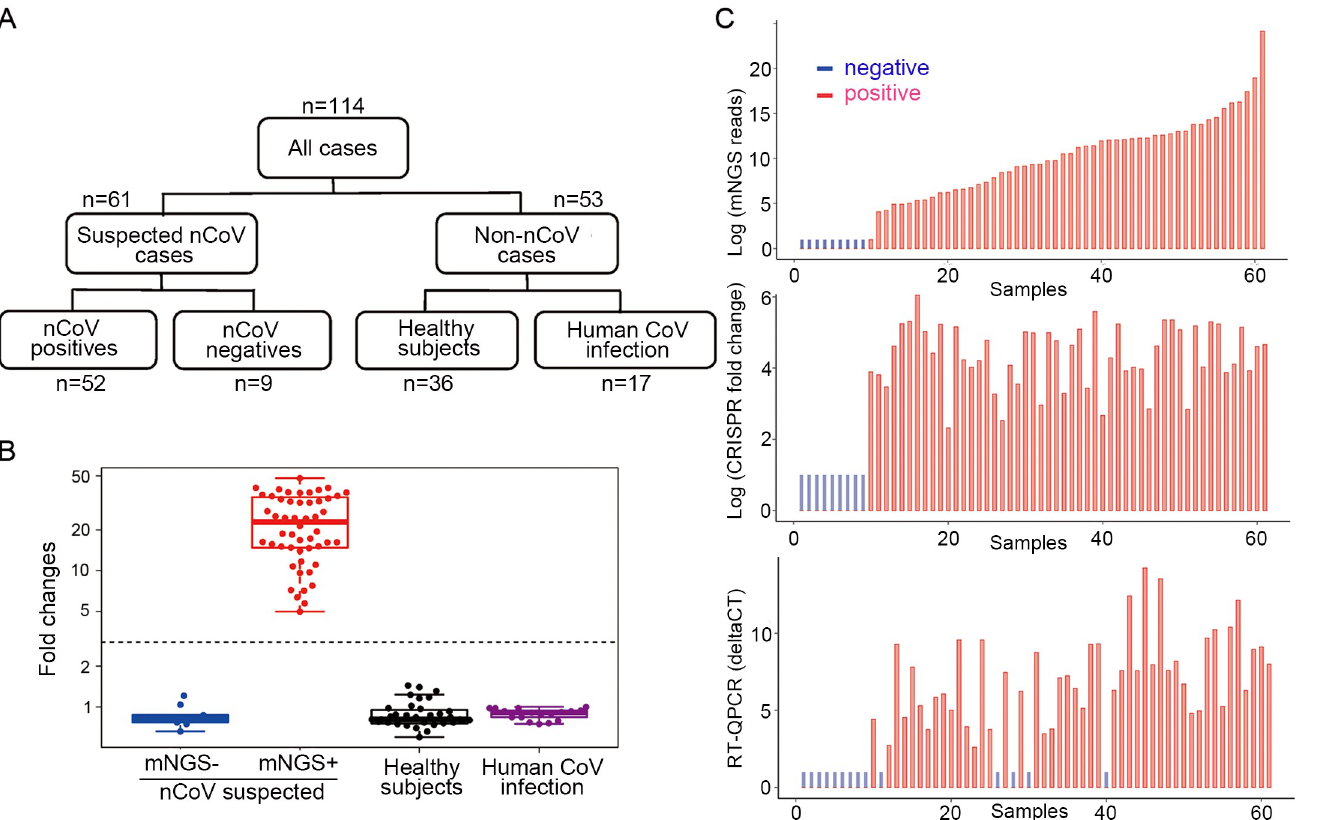
Fig 3. Summary of the cohort and CRISPR-COVID results. (A ) A total of 112 specimens included in this study, including 52 cases positive for SARS-CoV-2 and 62 negative cases. (B) Results of CRISPR-COVID in different sample groups. Positives and negatives were called based on the fold change and cutoff values; (C) Result summary on the suspected SARS-CoV-2 samples by mNGS, CRISPR-COVID and PCR-COVID. P = 0.056 between mNGS and RT-PCR, and between CRISPR and RT-PCR by Fisher’s exact test.